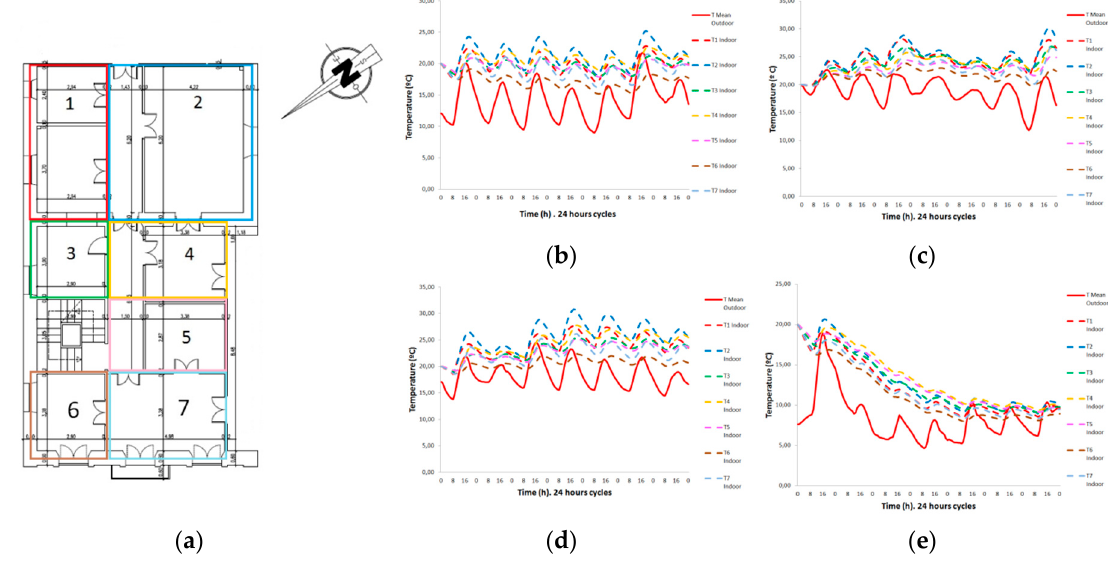
Figure 3. ( a ) Thermal zones on the galleries-removed first floor of the TAH, numbered from 1 to 7. T Mean Outdoor and 1–7 Thermal zones T Indoor from 22 to 28: ( a ) March ( b ) June ( c ) September ( d ) December.